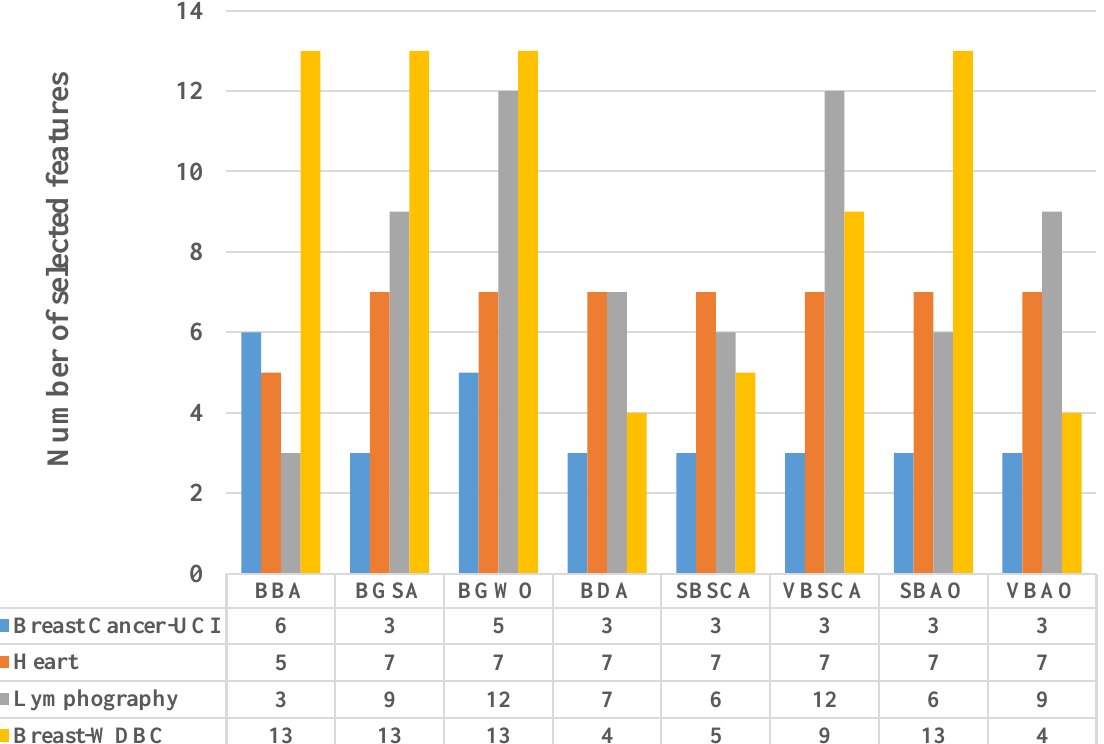
Figure 3. The Number of selected features comparison on small datasets.